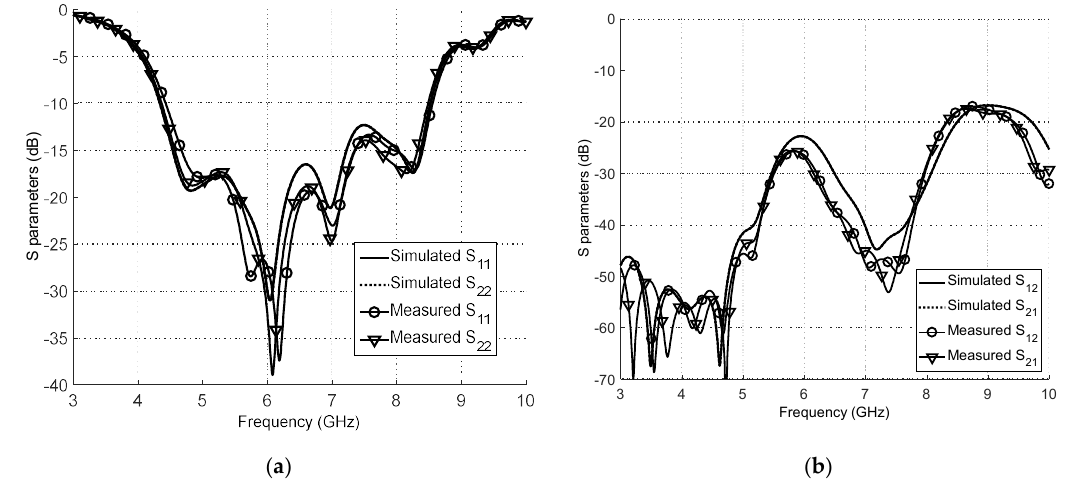
Figure 11. Measured and simulated results. ( a ) S 11 and S 22 , ( b ) S 12 and S 21 .